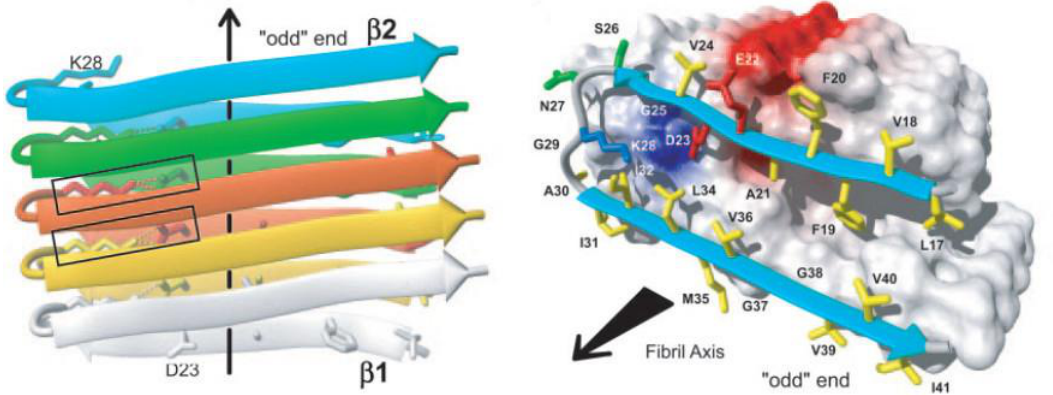
Figure 1. Cartoon of β-sheet amyloid structure based on NMR spectra. Notice the two beta- sheets folding upon one another and stacked in a parallel manner. Figure reprinted with permission from Luhrs, et al . 2005). Copyright 2005, National Academy of Sciences,